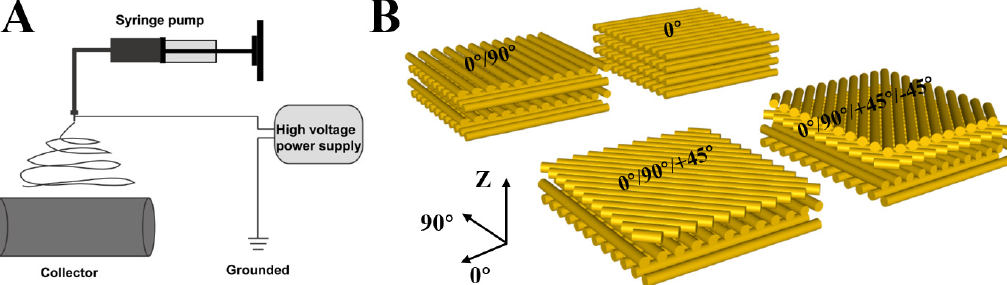
Figure 1: Schematic of electrospinning and four structures of PAN nanofibers: A) Schematic of electrospinning setup for collecting aligned PAN nanofibers; B) Schematic of 0 ∘ , 0 ∘ /90 ∘ , 0 ∘ /90 ∘ /+45 ∘ and 0 ∘ /90 ∘ /+45 ∘ / − 45 ∘ nanofiber